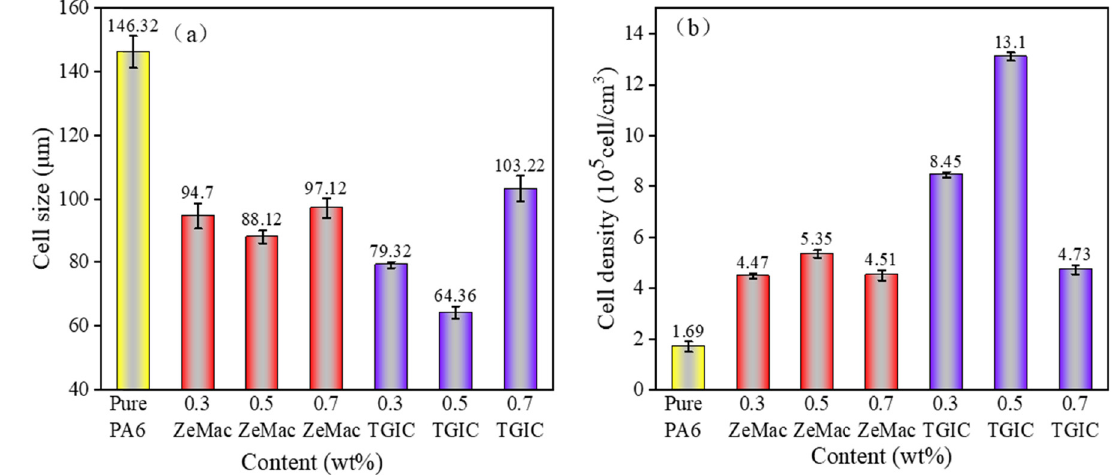
Figure 7: Average cell diameter ( a ) and cell density ( b ) of pure PA6 and modi fi ed